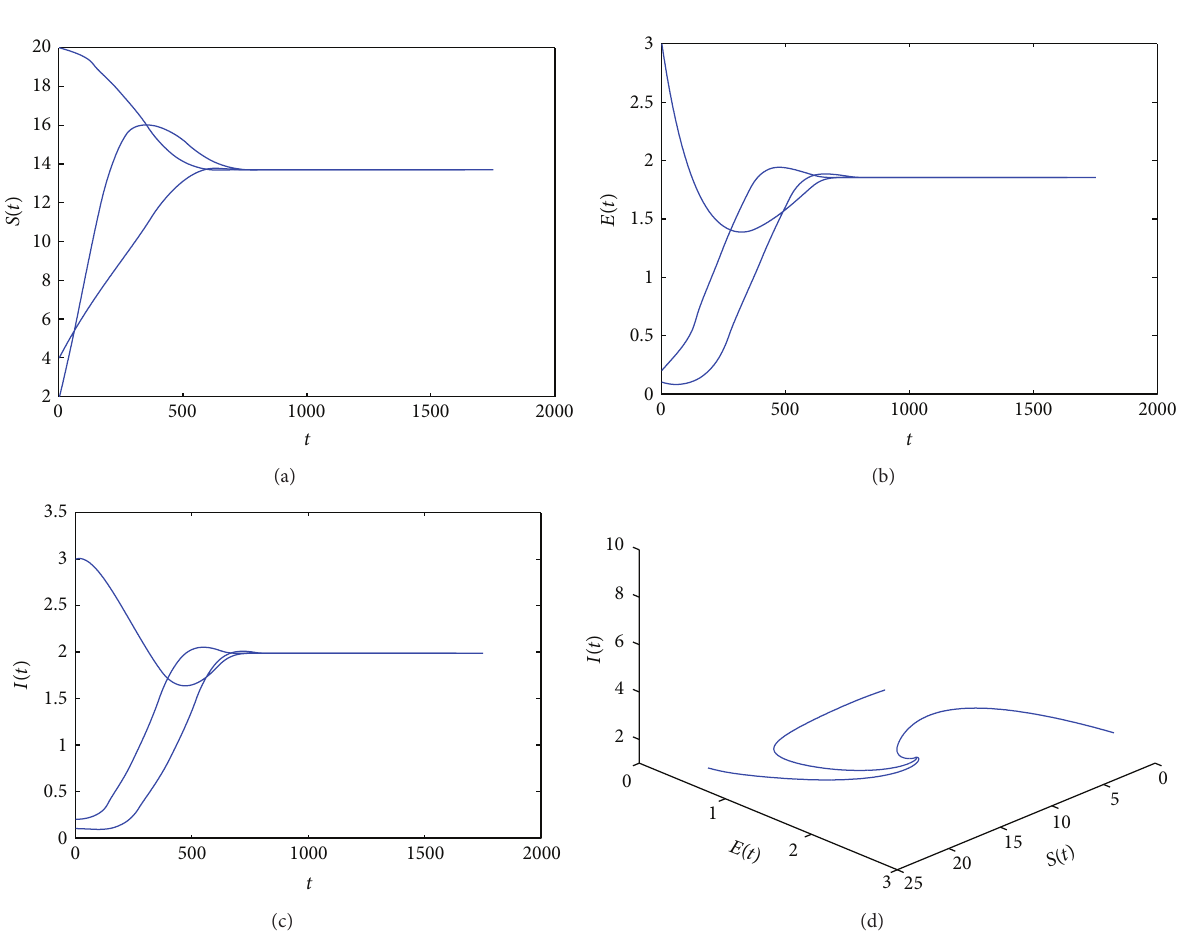
Figure 3: (a)–(d) show that system (7) has a disease-free equilibrium 𝐸 0 (50, 0, 0) , which is unstable, and an endemic equilibrium (13.6954573045, 1.8542772633, 1.9865335214) , which is locally asymptotically stable. In this case, 𝐴 = 10 , 𝛽 = 0.3 , 𝜀 = 1.2 , 𝑑 = 0.05 , 𝐸 ∗ 𝜇 = 0.2 , 𝜐 = 0.4 , 𝑟 = 0.1 , 𝛼 = 0.8 , and 𝑘 = 2 .